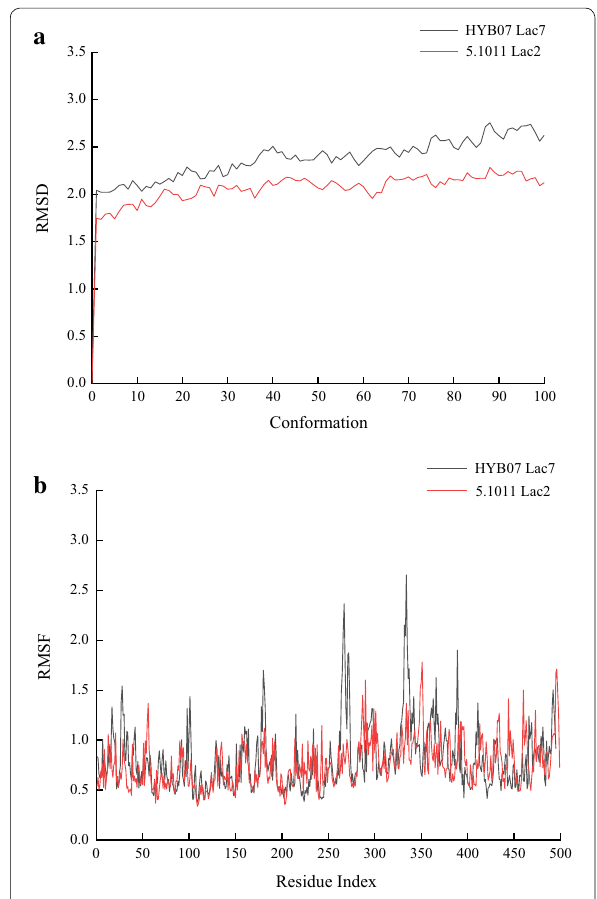
Fig. 7 Molecular Simulation of Lac2 from C. unicolor CGMCC 5.1011 and Lac7 from Cerrena sp. HYB07. a RMSD values of the laccases. b RMSF values of the